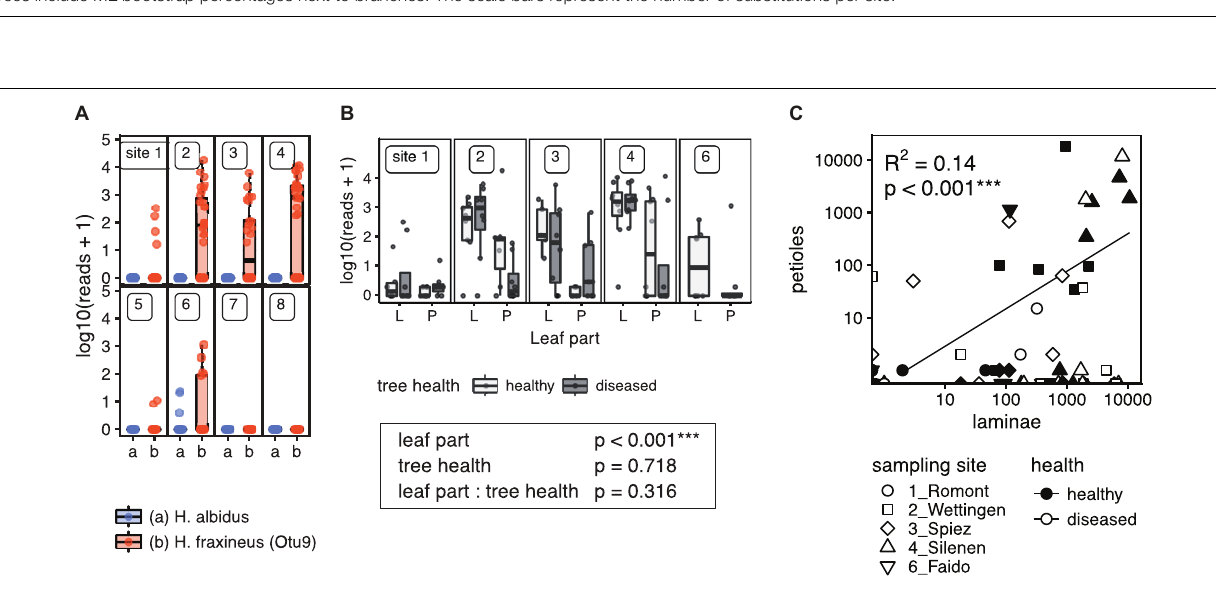
Frontiers in Microbiology |